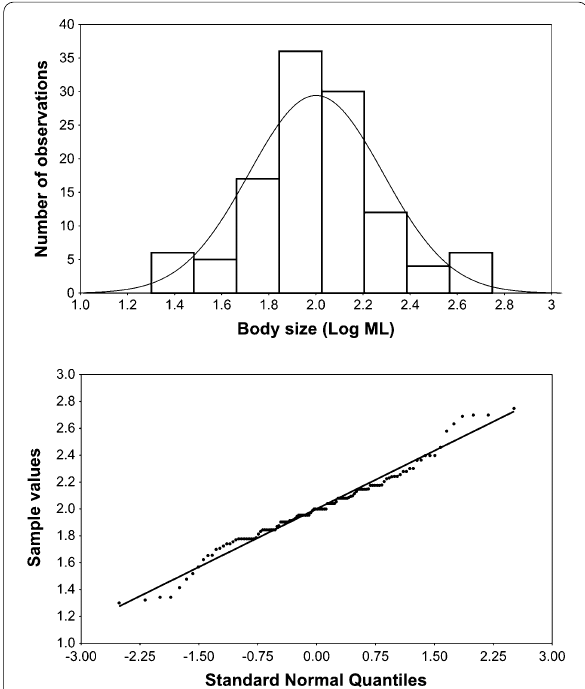
Fig. 4 Top: the frequency distribution of Log transformed body sizes of the cuttlefish species of the world ( n probability plot of the same data used to evaluate the skewness of the body size